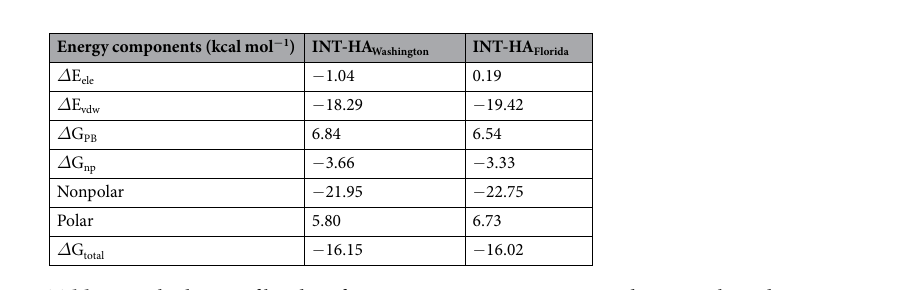
Table 3. Calculation of binding free energy using MM/PBSA under neutral